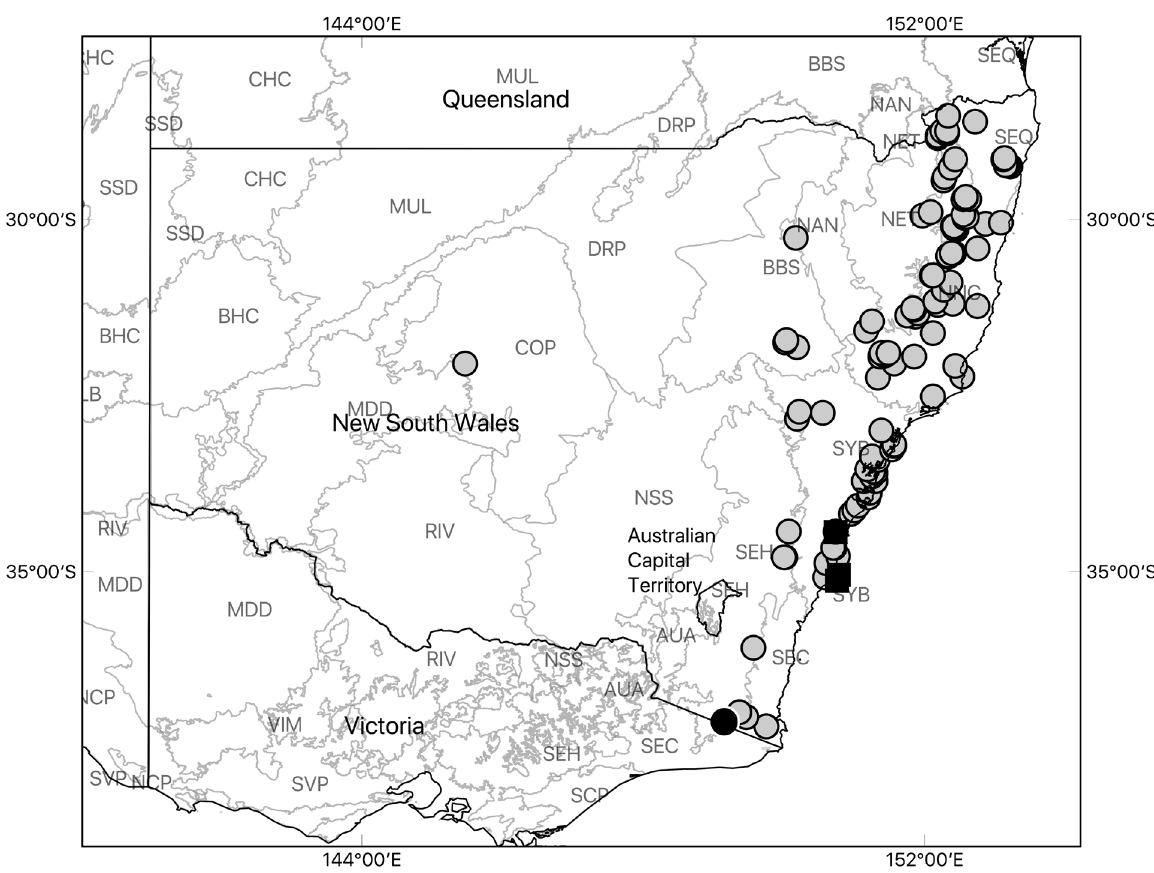
Figure 12. Distribution records of Artoria berenice (L. Koch, 1877) (grey circles), A. bondi sp. n. (full circle) and A. booderee sp. n. (full squares) in NSW. IBRA bioregions with spider records: BBS – Brigalow Belt South; MDD – Murray Darling Depression; NAN – Nandewar; NET – New England Tablelands; NNC – NSW North Coast; SEQ – South East Queensland; SEH – South East- ern Highlands; SEC – South East Corner; SYB – Sydney